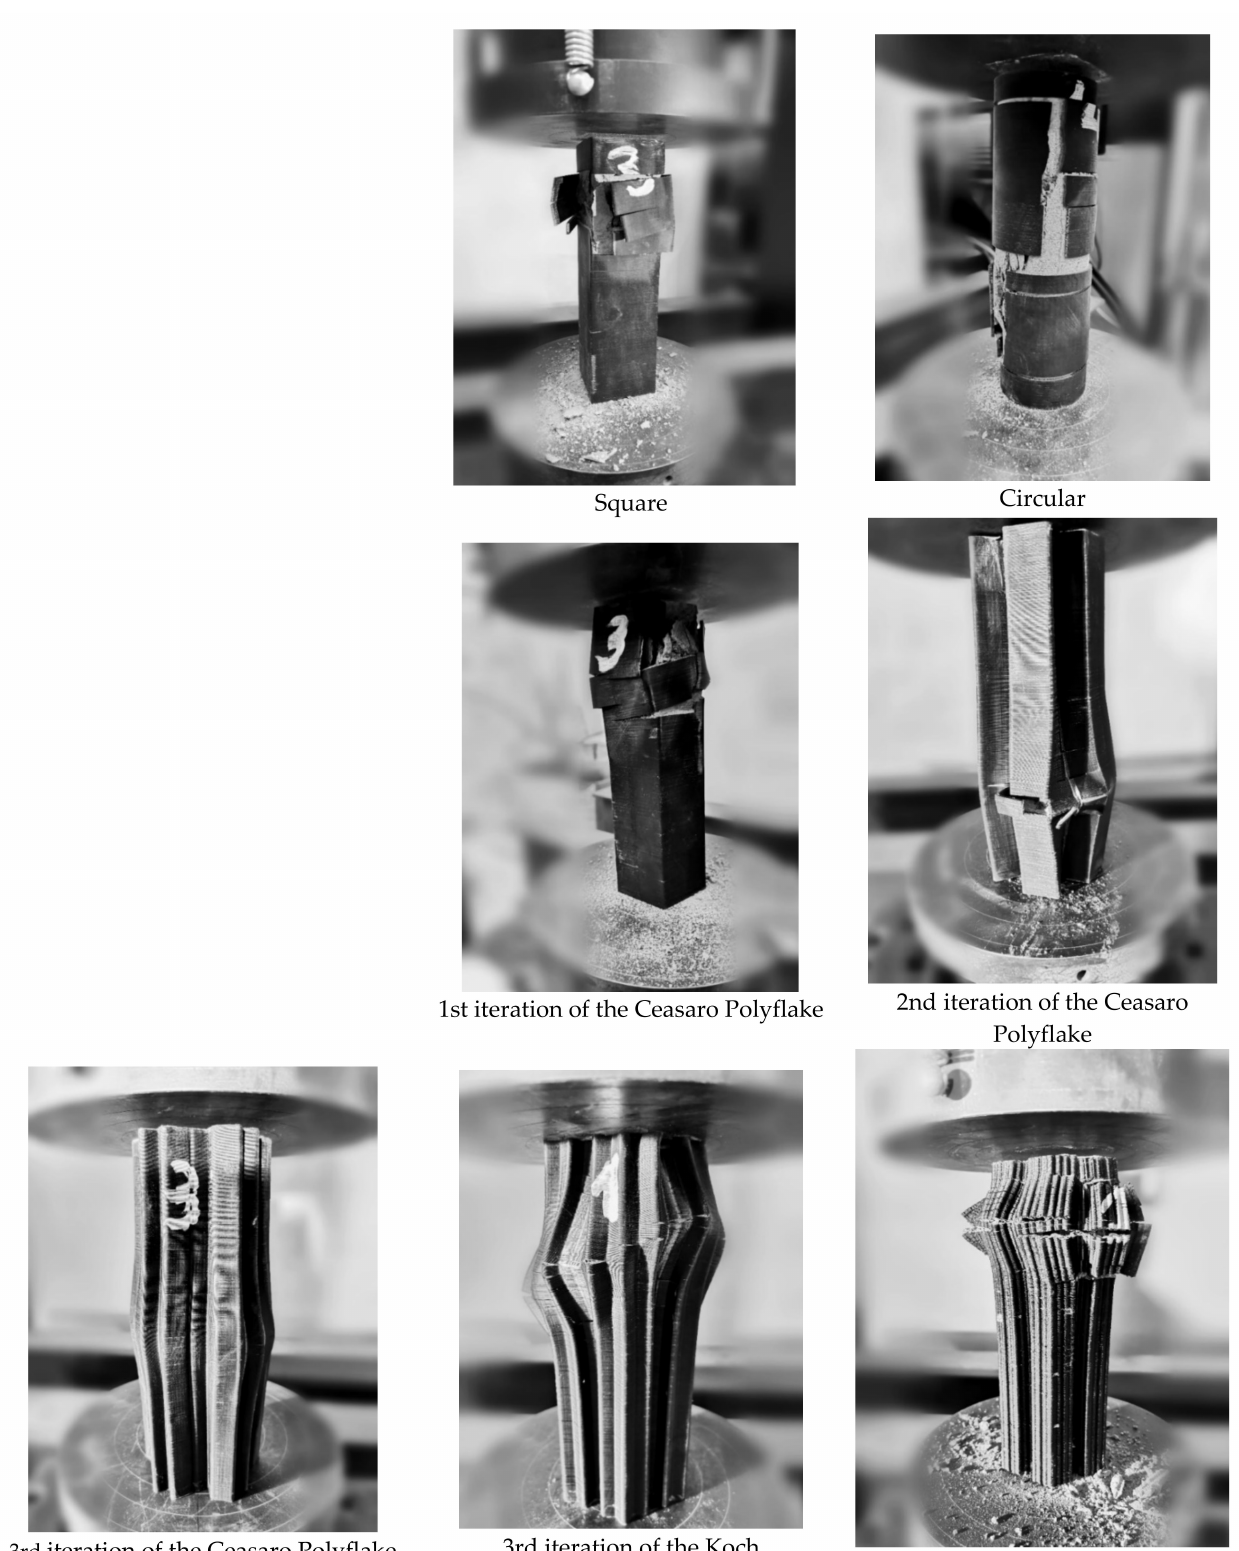
Figure 6. Images of specimens after